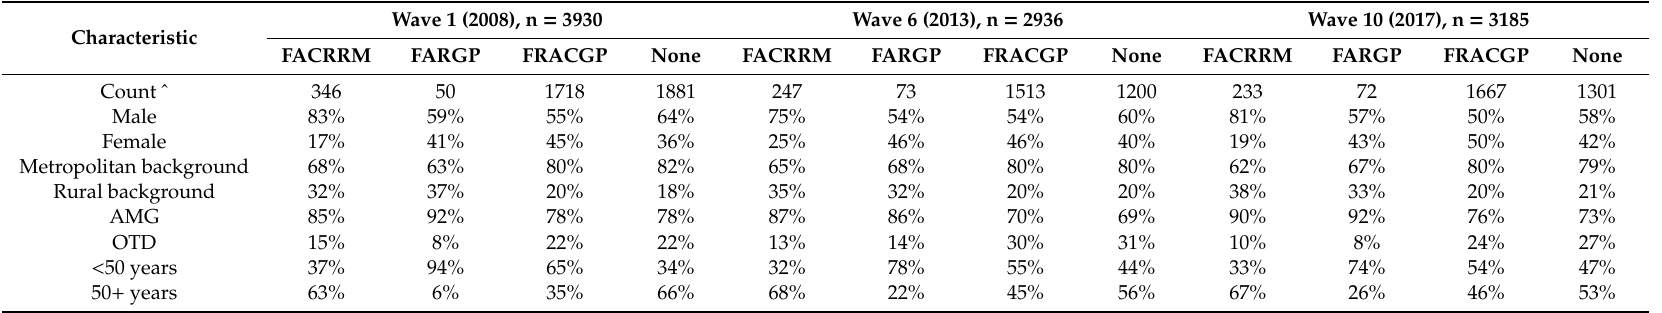
Table 3. Demographics of GP participants by fellowship group.